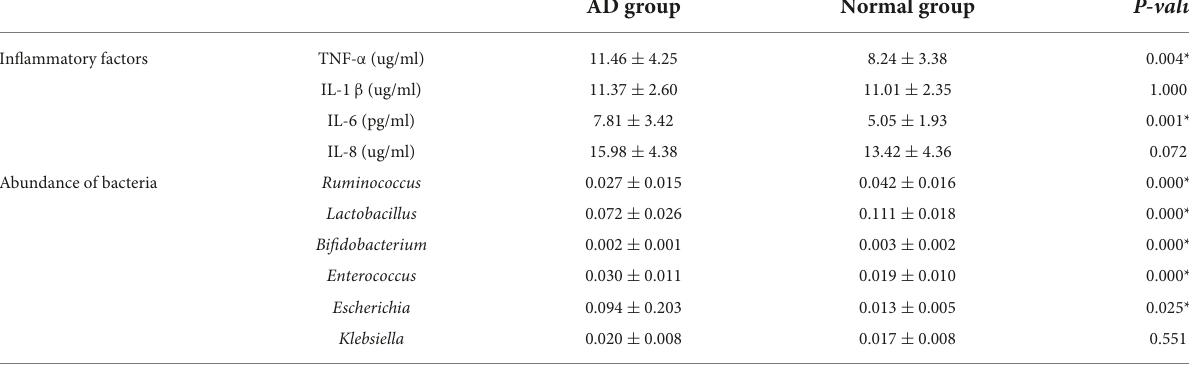
TABLE 5 Inflammatory factors and abundance of anti-inflammatory bacteria and pro-inflammatory bacteria in each group. AD group Normal group